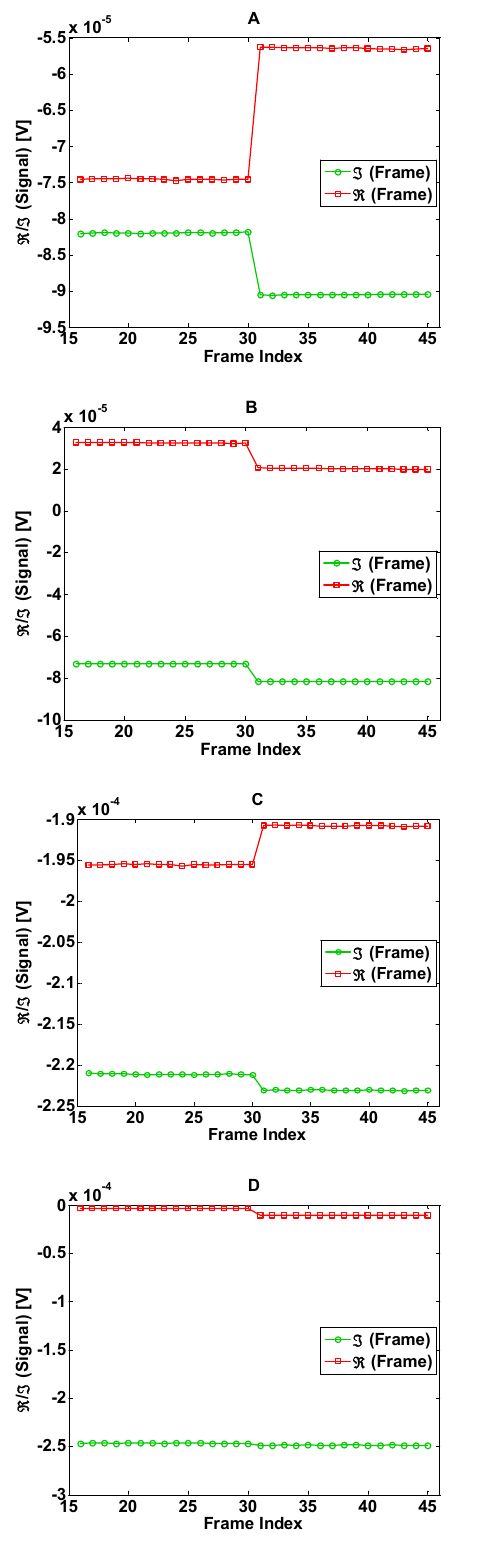
Fig. 7: Acquired real and imaginary frames of the total received signal before and after medium rotation in the error detection measurements . A: with an active marker at 500 kHz , B: with a passive marker at 500 kHz , C: with an active marker at 200 kHz , D: with a passive marker at 200 kHz . Green curve: imaginary signal showing the signal error Im(Δ v error ) to be eliminated; red curve: real signal showing the detection signal Re(Δ v error ) to be used to detect Im(Δ v error ) . Note the differently scaled y-axes of the graphs. The first invisible 15 frames (1 - 15) were used for phase calibration purposes [13] and are therefore not shown.